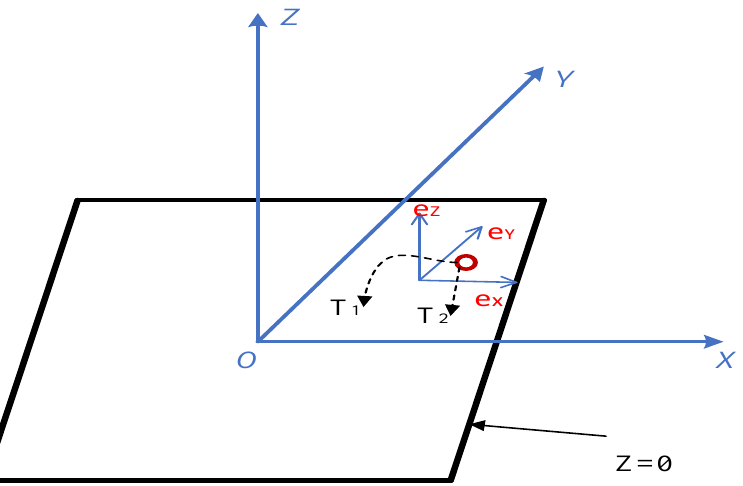
Figure 2. Thin plate space coordinate